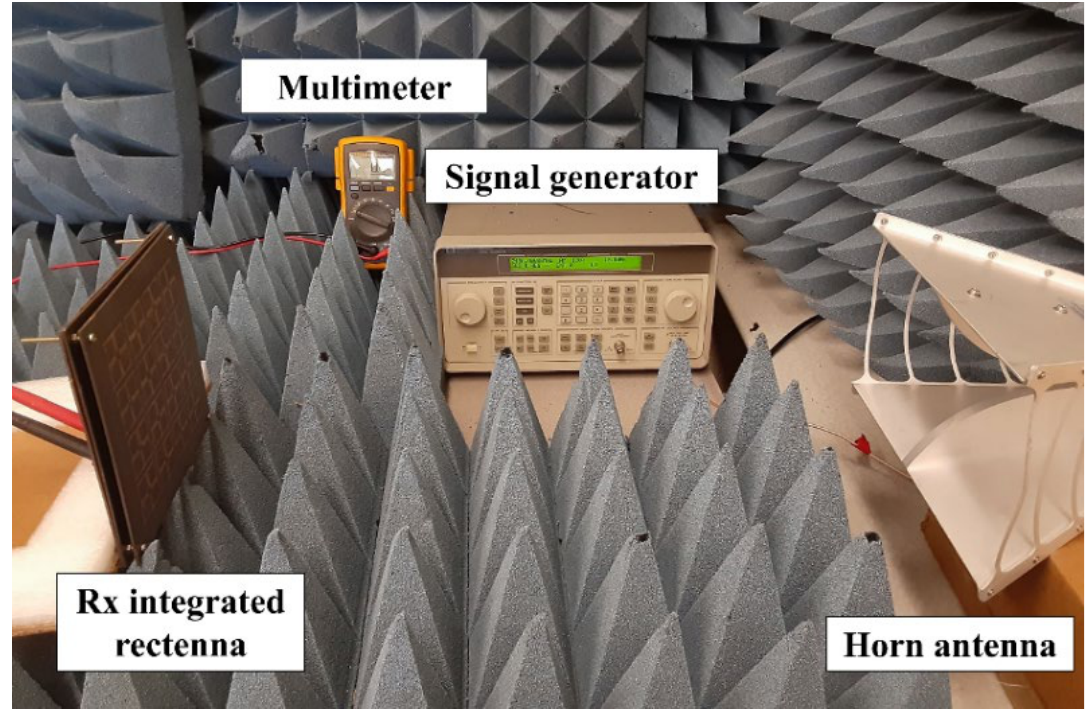
Figure 13. Measurement setup for the MTM-integrated rectenna.